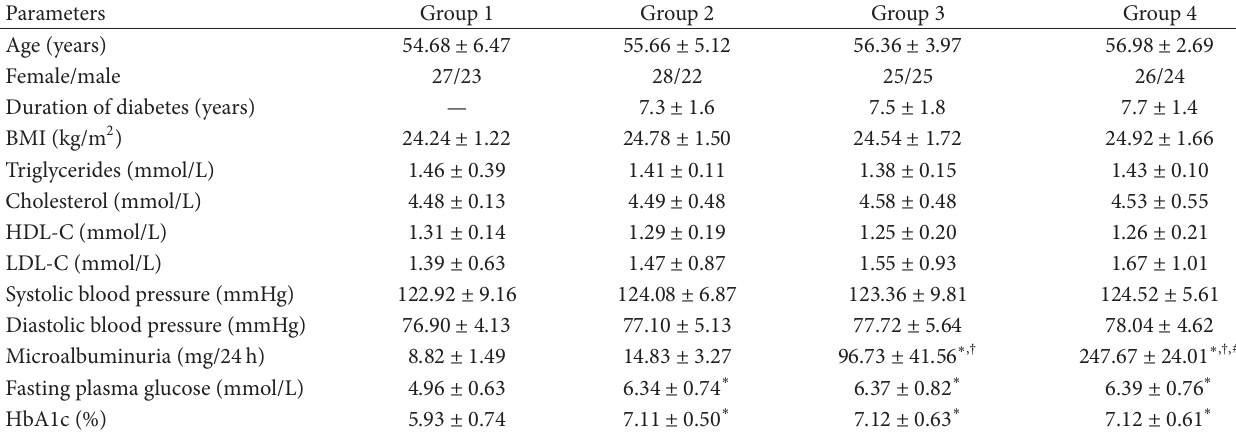
per group). 𝑛𝑛 𝑛 𝑛𝑛